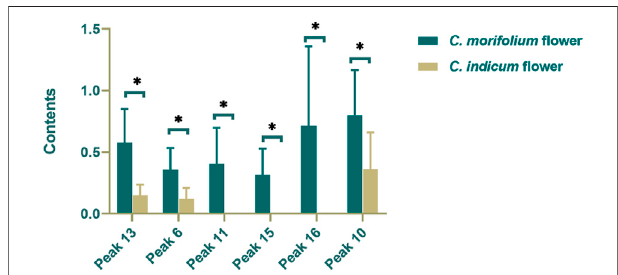
FIGURE 6 | Contents of markers in C. indicum fl ower (CI) and C. morifolium fl ower. (* p <